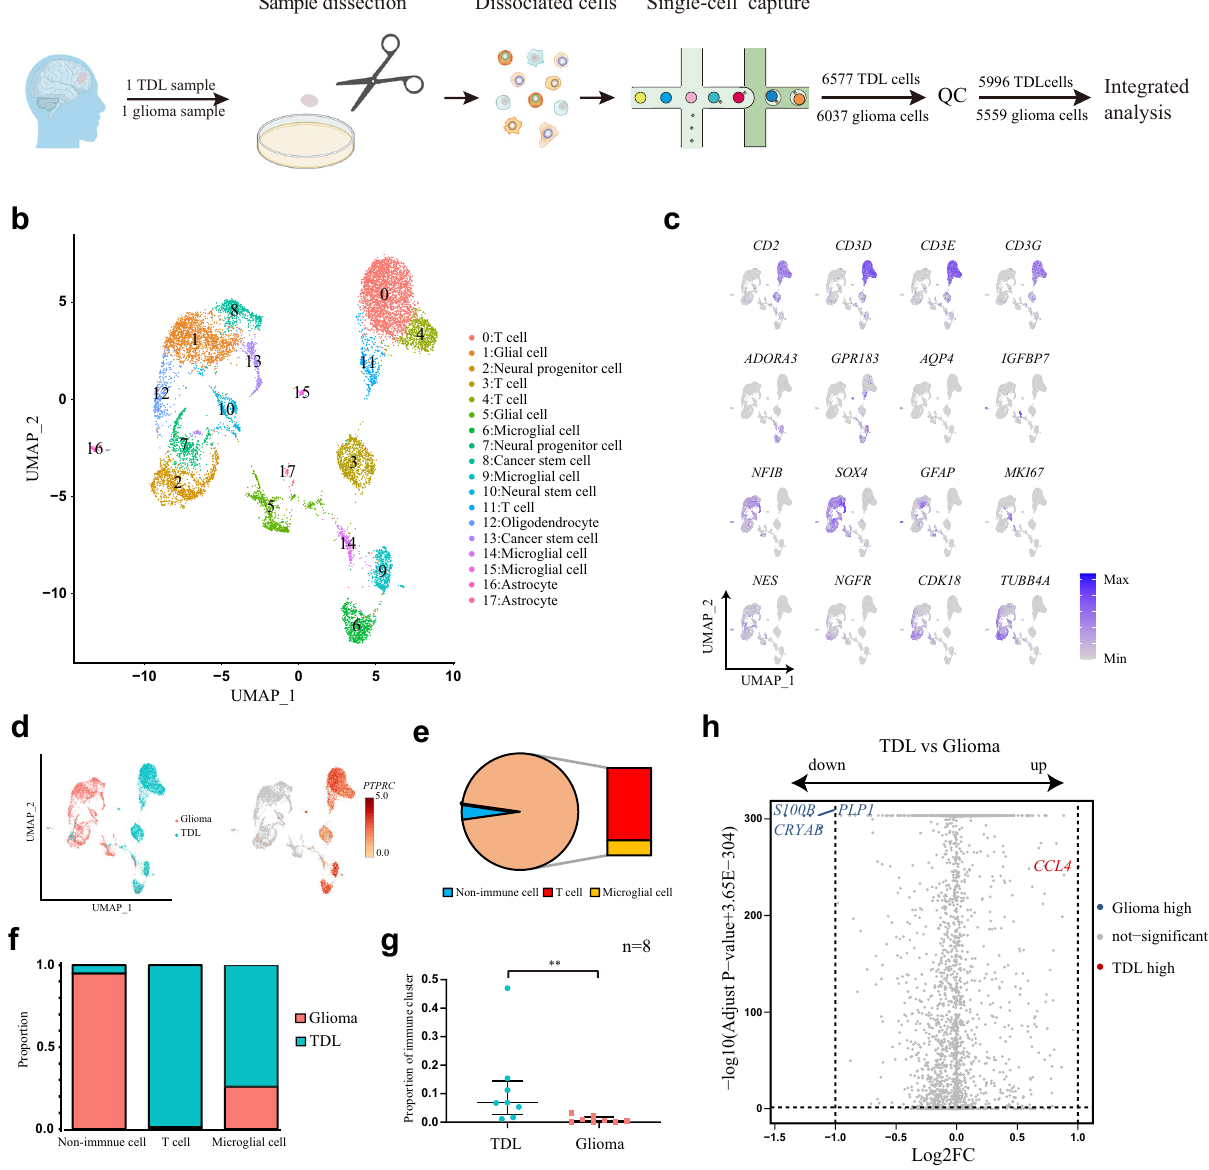
Fig. 1 The difference of cell-type composition and transcriptomic level between glioma and TDL. a Work fl ow diagram (Created with BioRender.com) showing the collection and processing of fresh samples from a high-grade glioma and a TDL for integrated analysis. b UMAP plot of cells from the two samples pro fi led in this study, with each color and number coded to indicate the associated cell types. c Feature plots of canonical markers for identify cell types after automatic annotation. d UMAP plot indicating the distribution of cells from TDL and glioma with corresponding color (left) and expression level of PTPRC in cells (right). e Proportion plot of cell-type composition in TDL. f Cell-type composition between TDL and glioma. g Comparison of proportion of immune clusters in TDL and glioma by nonparametric test (Mann – Whitney test). The data are expressed as median (interquartile range); n = 8 independent samples. A P -value < 0.05 was considered signi fi cant (* P < 0.05; ** P < 0.01). h Volcano plot of differentially expressed genes (DEGs) that are upregulated (red) or downregulated (blue) in cells of TDL by comparing to cells of glioma. TDL tumefactive demyelinating lesion, QC quality control, UMAP Uniform Manifold Approximation and Projection, FC fold change.